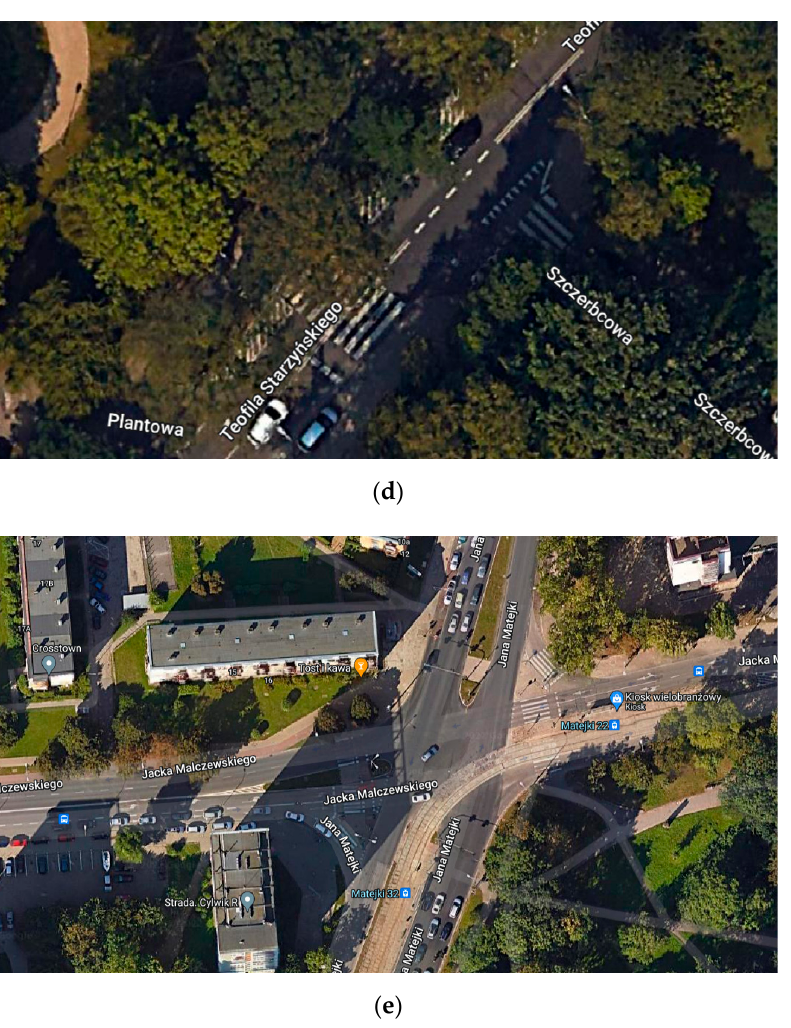
Figure 2. Satellite view of the examined crosswalks. ( a ) Crossroads no. 1; ( b ) Crossroads no. 2; ( c ) Crossroads no. 3; ( d ) Crossroads no. 4; ( e ) Crossroads no. 5.